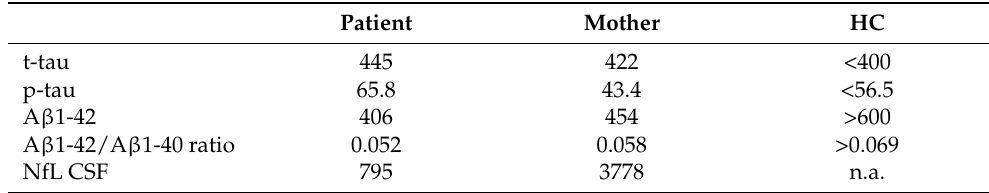
Table 2. Biomarkers